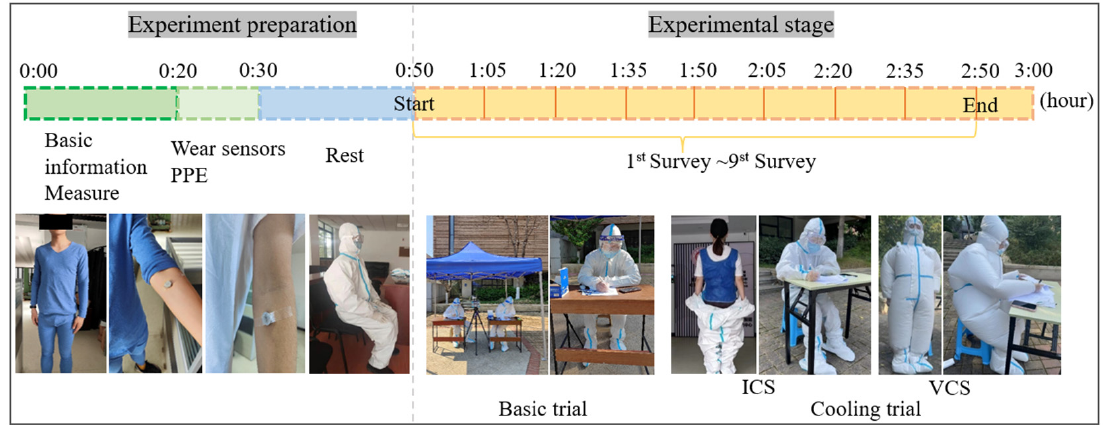
Figure 3. Schematic showing details of experimental procedures.